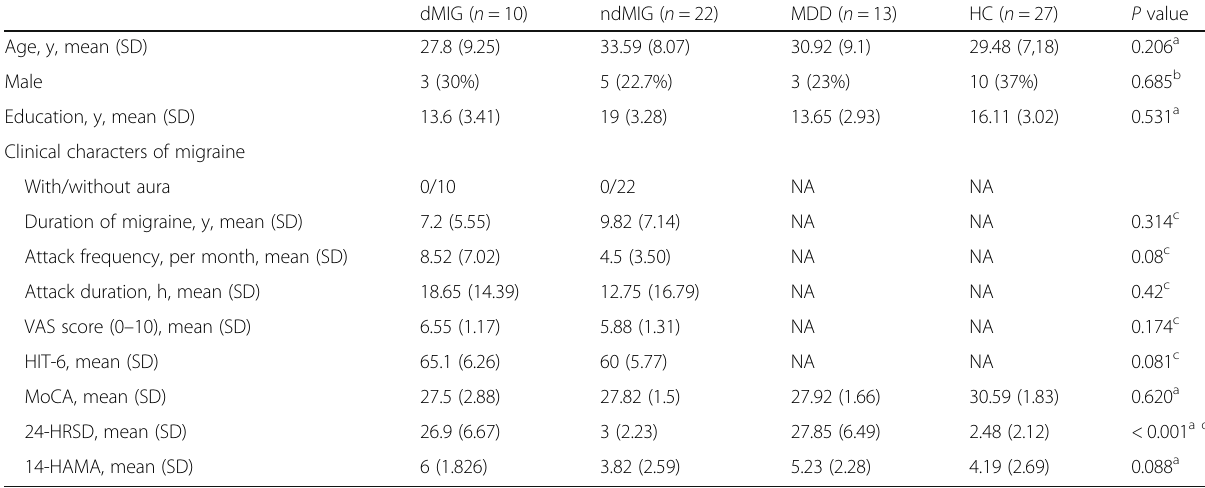
Table 1 Demographic and clinical characteristics of all